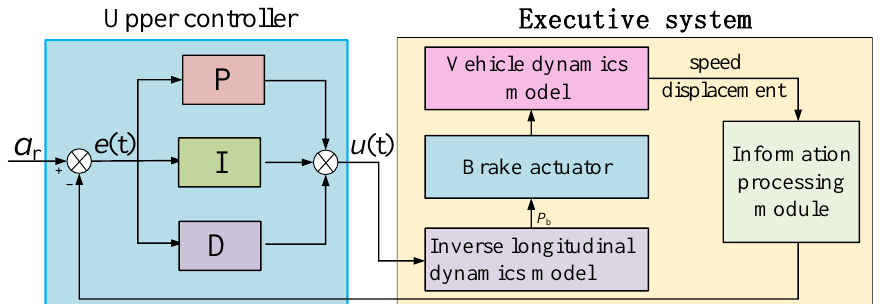
Figure 4. Control flow graph of the upper-layer controller.